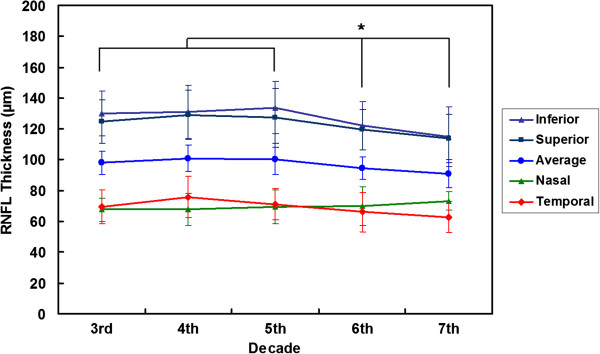
Peripapillary retinal nerve fiber layer thickness according to age in healthy Koreans. Asterisks indicate statistically significant differences (p < 0.050).